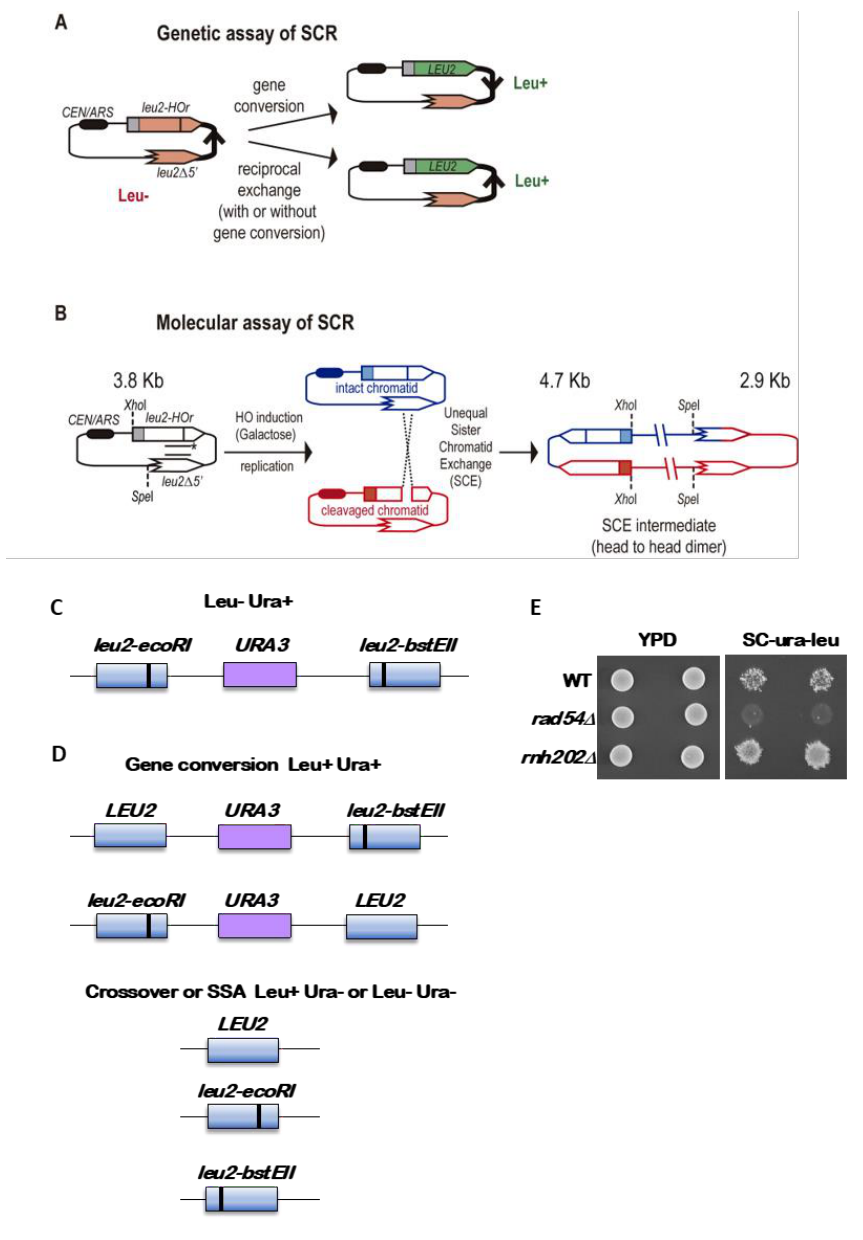
FIGURE 2: Assays to detect chromatid recombination. (A) Genetic assay of sister chromatid recombination